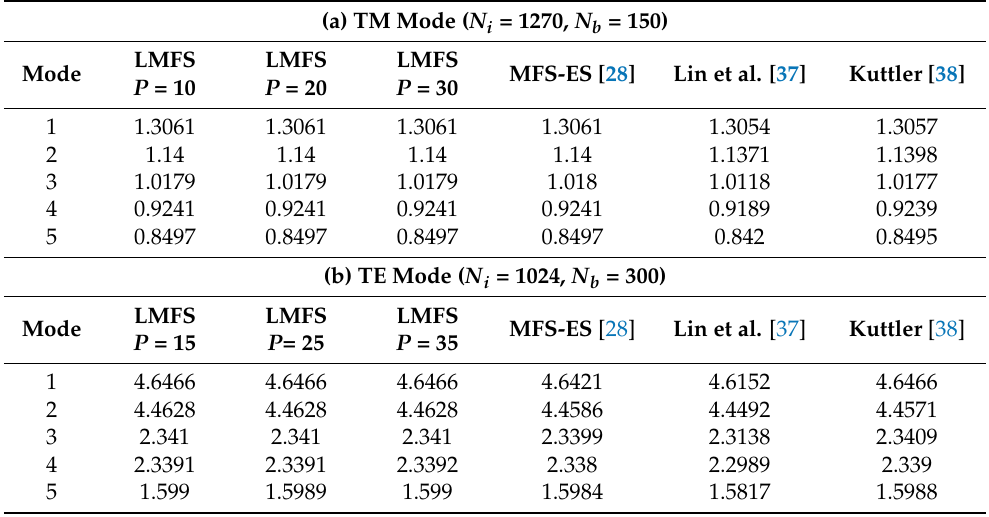
Table 3. Comparison of the first five cutoff wavelengths for the eccentric annular waveguide in case